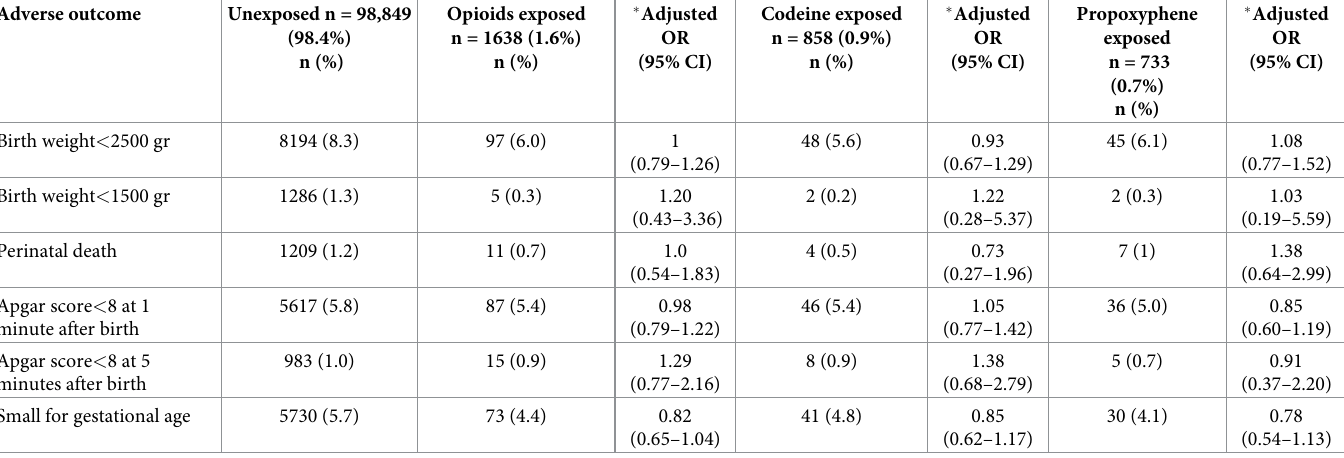
Table 4. Odds ratios for adverse pregnancy outcomes (other than malformations) following third trimester intrauterine exposure to opioids, and specifically to codeine or to propoxyphene alone, compared to unexposed. Adverse